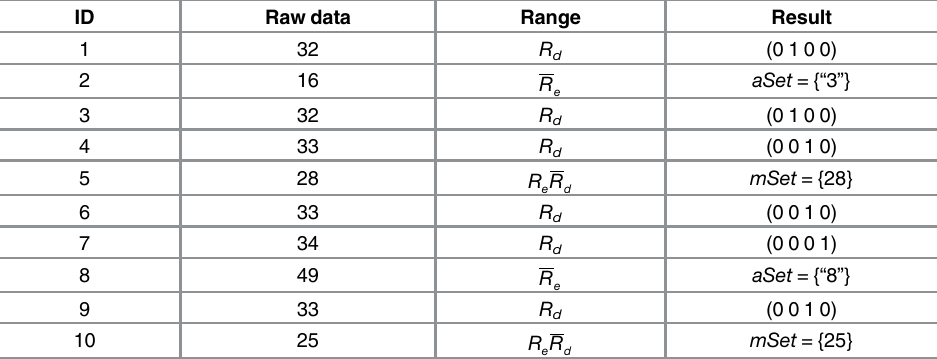
Table 1. Example for